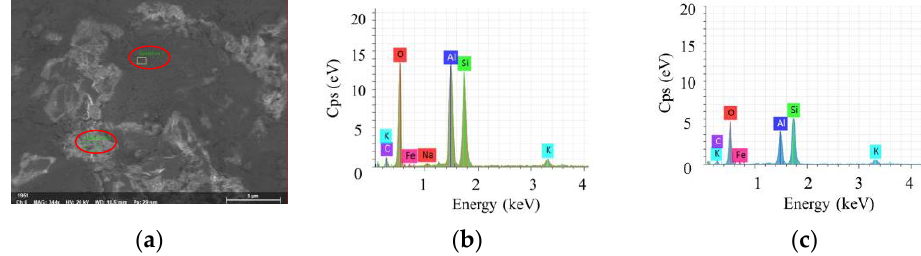
Figure 1. EDS analysis results. ( a ) EDS sampling point; ( b ) Element at point 1; ( c ) Element at point 2. Table 1. Chemical solution.